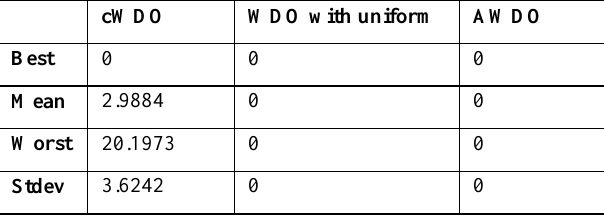
Figure 1. Flowchart of the adaptive WDO algorithm.